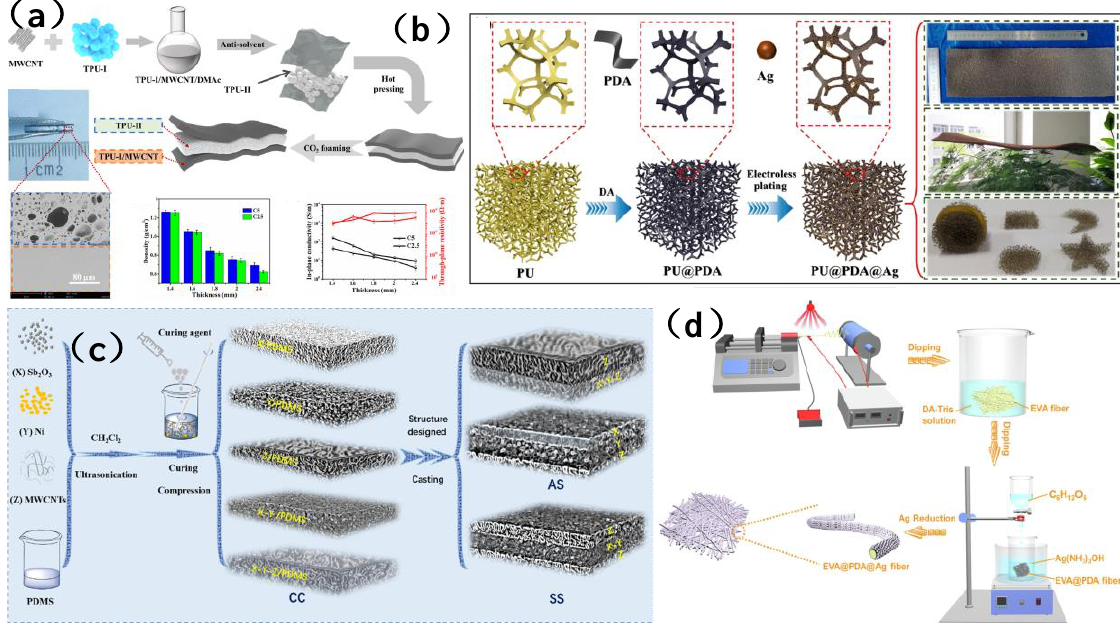
Figure 8. ( a ) Schematic diagram of the preparation process leading to TPU/MWCNTs of its structure and performance [109]. Copyright 2020, Elsevier. ( b ) Schematic diagram of the preparation and performance evaluation of PU@PDA@Ag [111]. Copyright 2020, Elsevier. ( c ) Schematic diagram of the manufacturing process leading to traditional Sb 2 O 3 -Ni-MWCNTs/PDMS composite (CC), asymmetric structure composite (AS) and symmetric structure composite (ss) [107]. Copyright 2022, Elsevier. ( d ) Schematic diagram showing the preparation of EVA@PDA@Ag fiber composites [28]. Copyright 2022,